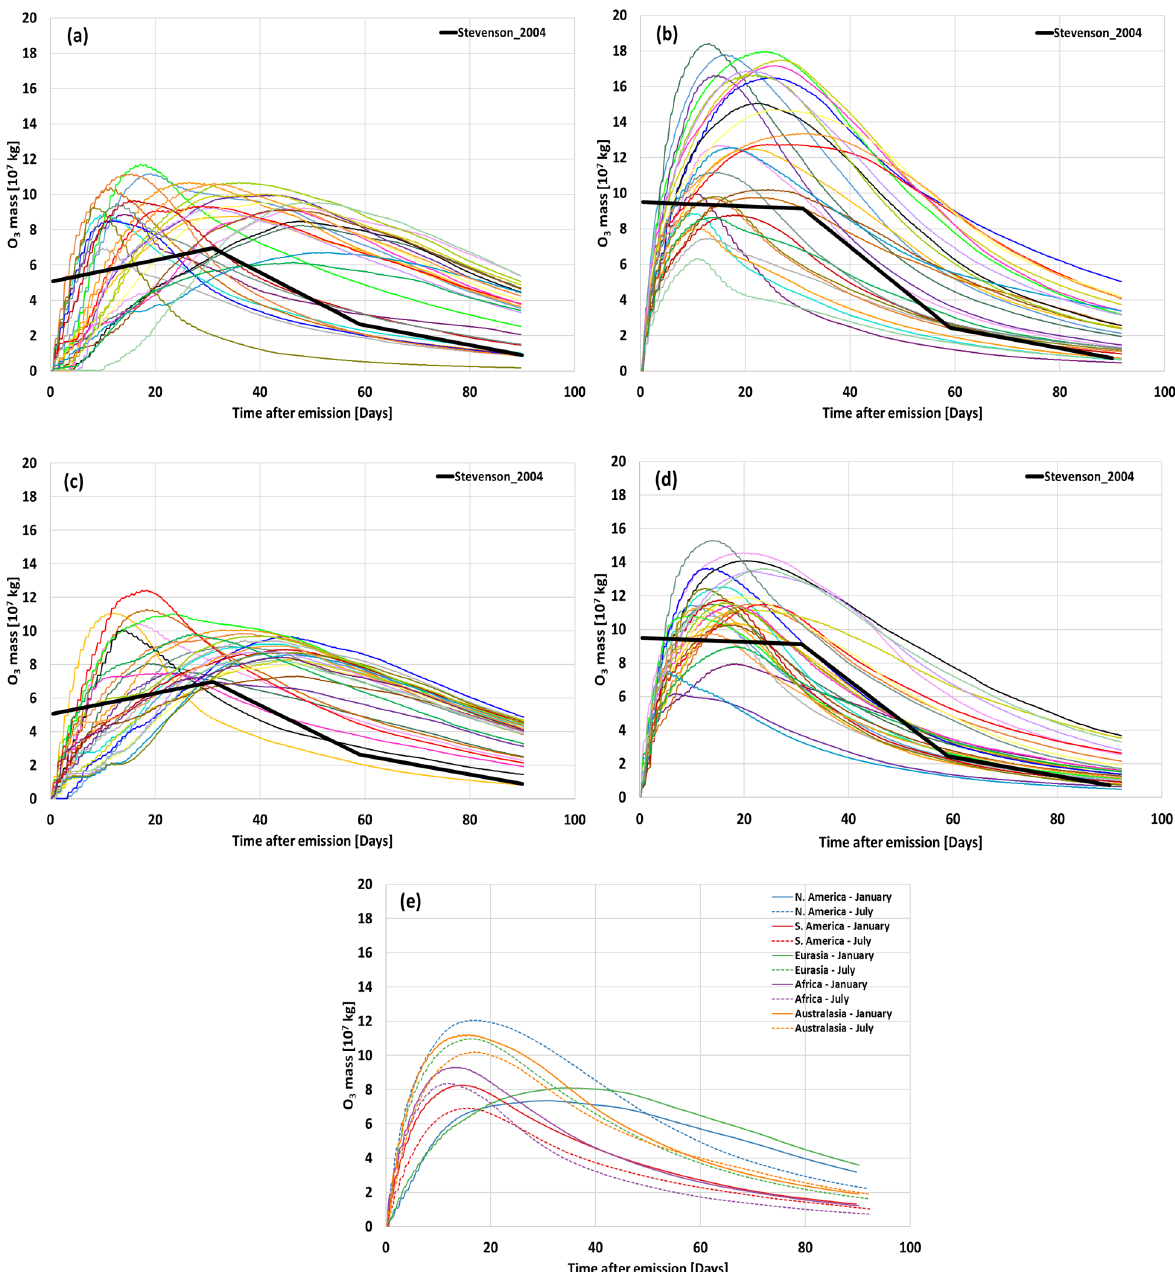
Figure 15. The colored lines represent the mean temporal evolution of the NO x -induced short-term O 3 mass, in kilograms, across 50 air parcel trajectories that are initialized in each of the 28 emission points for N. America during January (a) and July (b) as well as for Eurasia during January (c) and July (d) . The thicker dark line represents scaled results from Stevenson et al. (2004) to adjust to the same initial NO x that is released in this study. The scaling factor for a January NO x emission is 6 . 97 × 10 − 3 and for a July NO x emission is 1 . 22 × 10 − 2 . The O 3 averaged across all 28 emissions for each region and season is represented in (e)